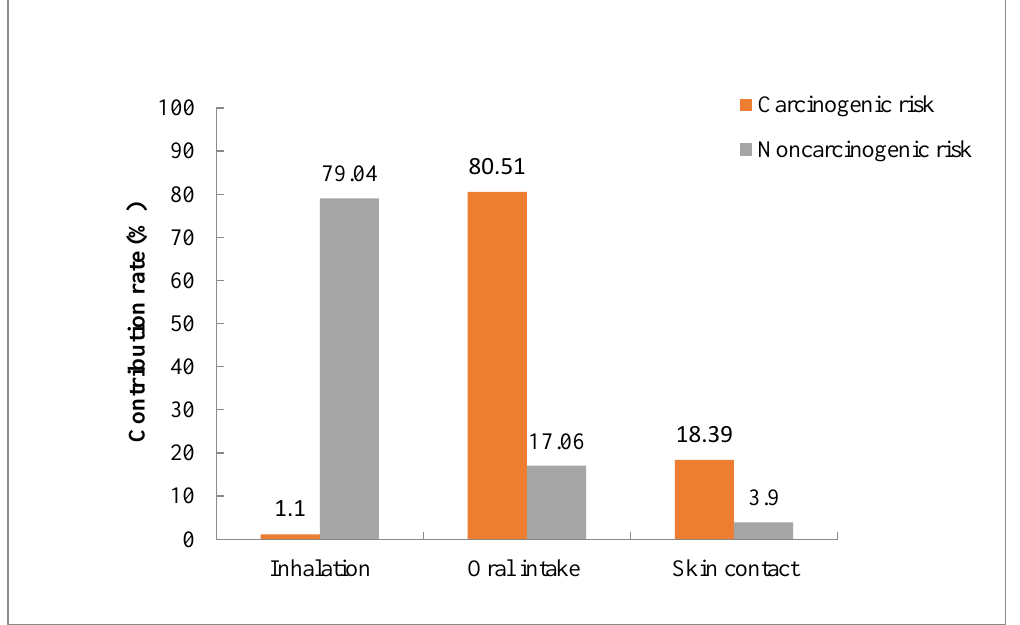
Figure 5. Carcinogenic risk and noncarcinogenic risk contribution rate of cadmium from three exposure pathway.